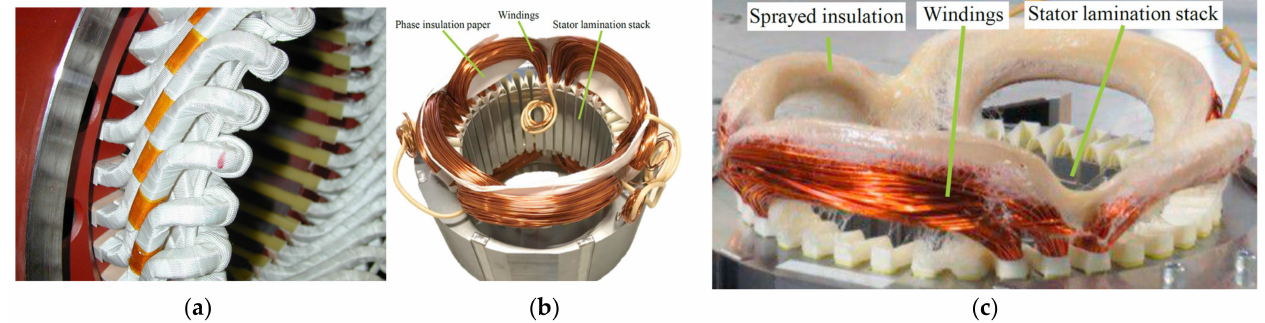
Figure 13. Different insulation methods. ( a ) A sophisticated insulation for high rating electrical machines [57]; ( b ) conventional interphase insulation paper [58]; ( c ) spray insulated winding